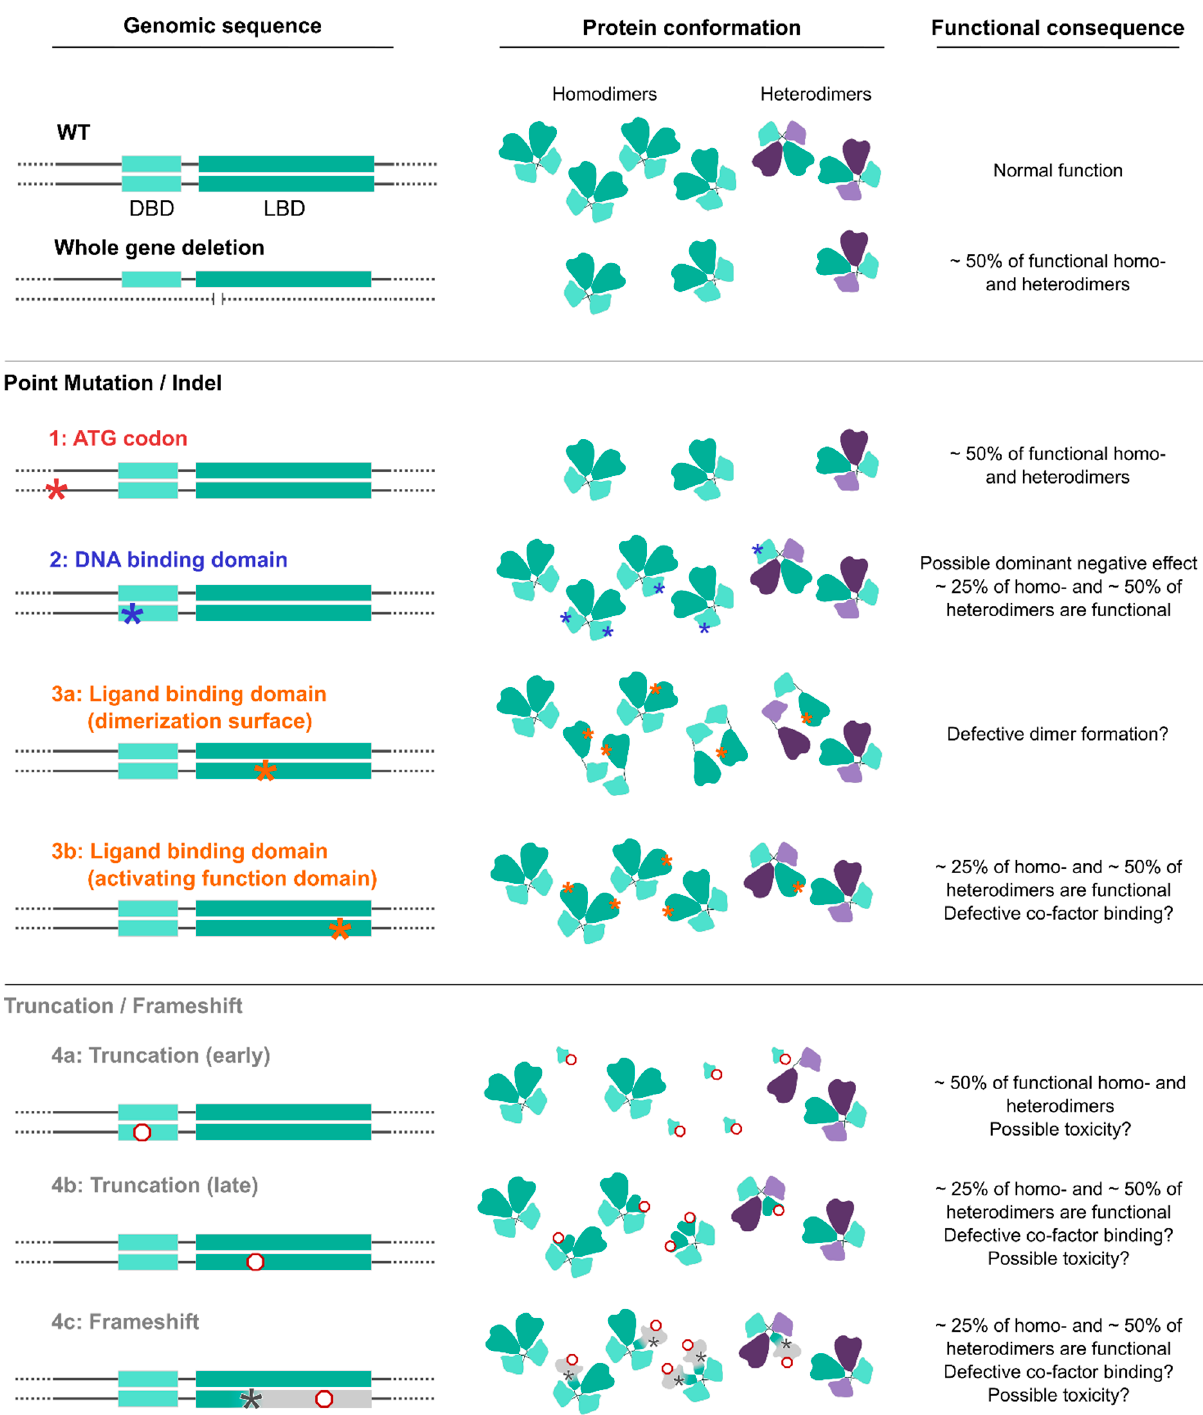
Figure 4. NR2F1 molecular functioning and dimer formation hypothetical predictions upon distinct genetic perturbations . Distinct deletions and mutations affecting NR2F1 genomic sequence (left column) could result in specific scenarios of impaired quantity and/or quality of NR2F1 homo- and heterodimers (central and right columns), possibly explaining a genotype–phenotype correlation. While decreased NR2F1 expression has been proven for some ATG point variants and